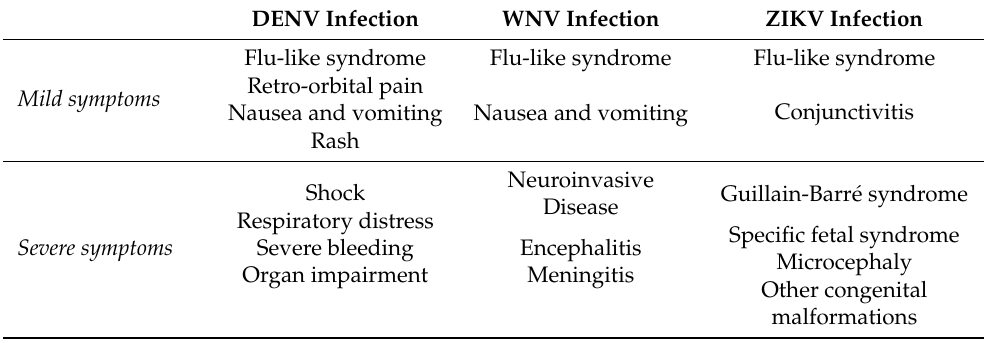
Table 1. Flavivirus infections outcomes, including severe symptoms that may lead to fatalities. DENV Infection WNV Infection ZIKV Infection Flu-like syndrome Flu-like syndrome Flu-like syndrome Retro-orbital pain Mild symptoms Nausea and vomiting ConjunctivitisNausea and vomiting Rash Shock Guillain-Barr é syndrome Disease Respiratory distress Specific fetal syndrome Severe symptoms Encephalitis Severe bleeding Microcephaly Meningitis Organ impairment Other congenital